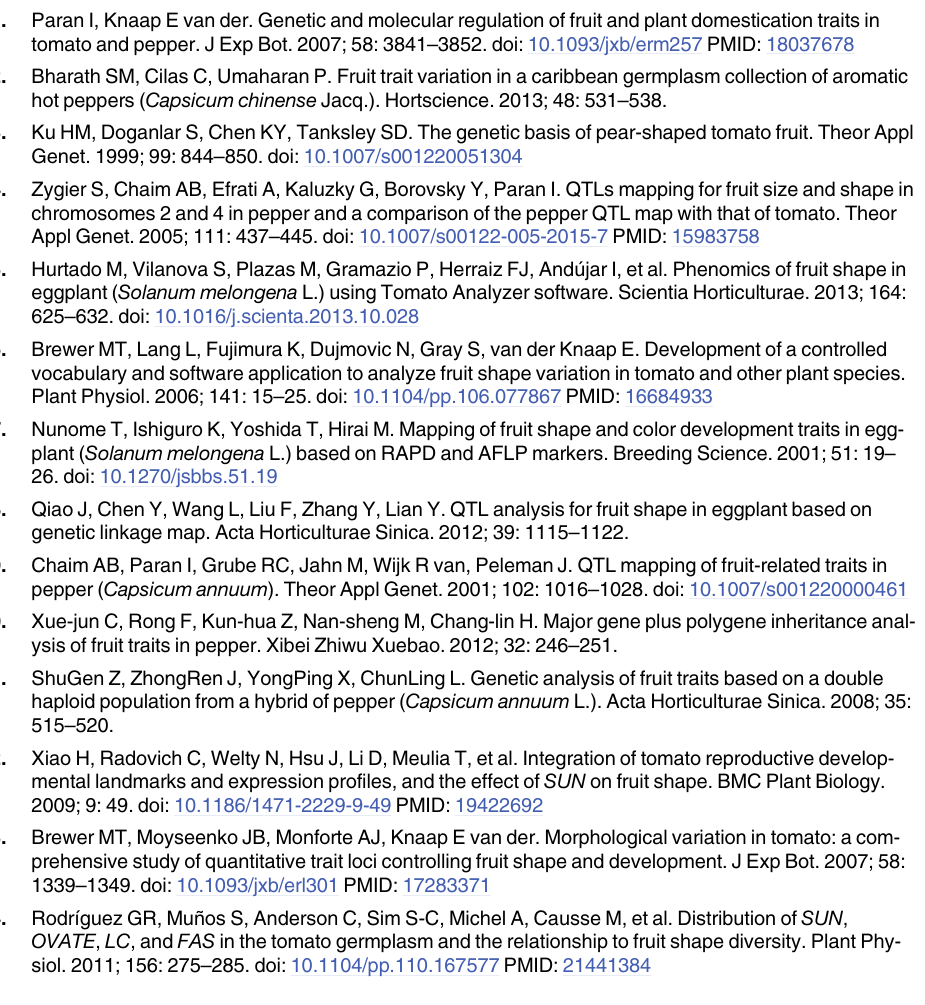
S2 Table. Pearson Correlation Coefficients for fruit traits.